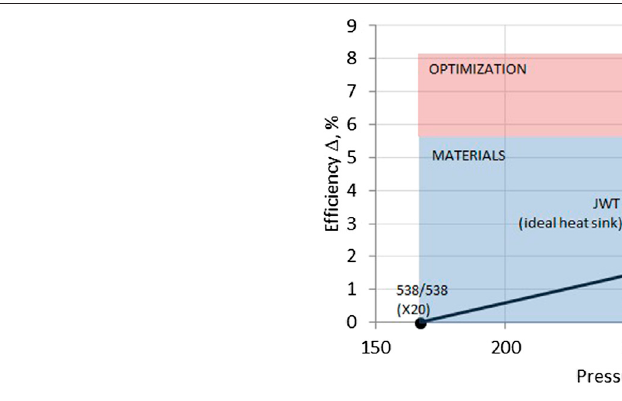
FIGURE 8 | Steam turbine power plant ef fi ciency improvement